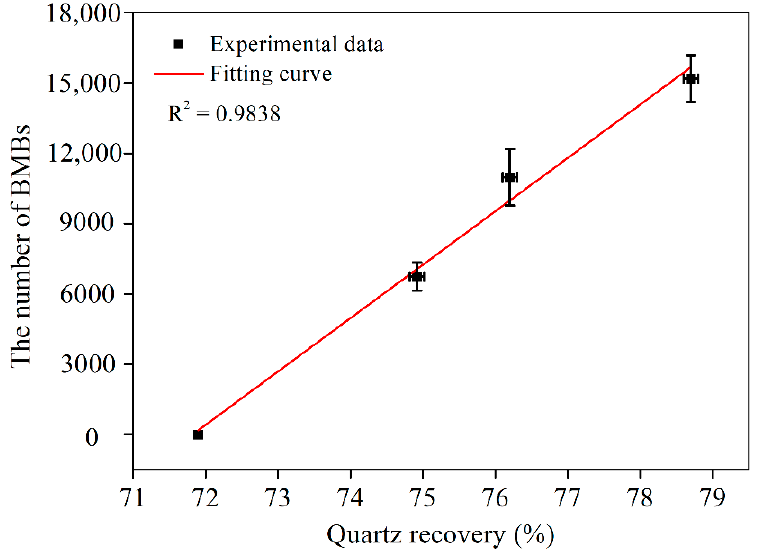
Figure 11. Number of BMBs (>1 μ m) as a function of flotation recovery (under various aging times).